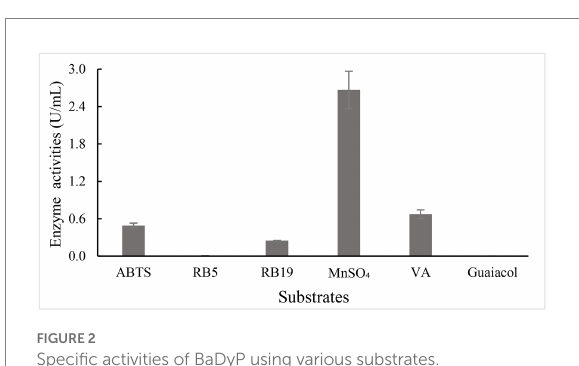
FIGURE 2 Specific activities of BaDyP using various